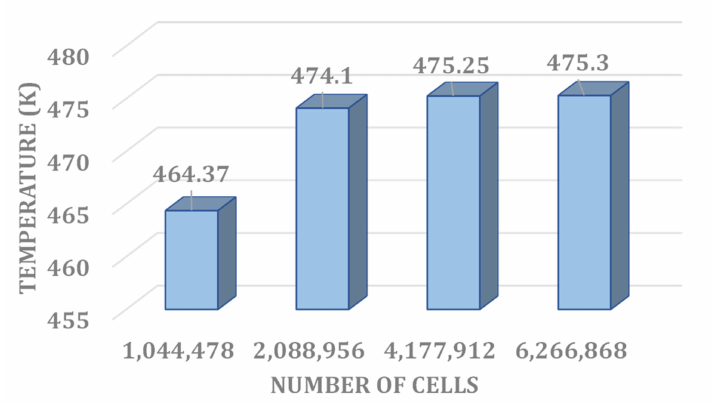
Figure 11. Grid independency study of the three-dimensional CFD model of the TEG unit considering the temperature in the engine mode D given by Table 2 as the verification value.